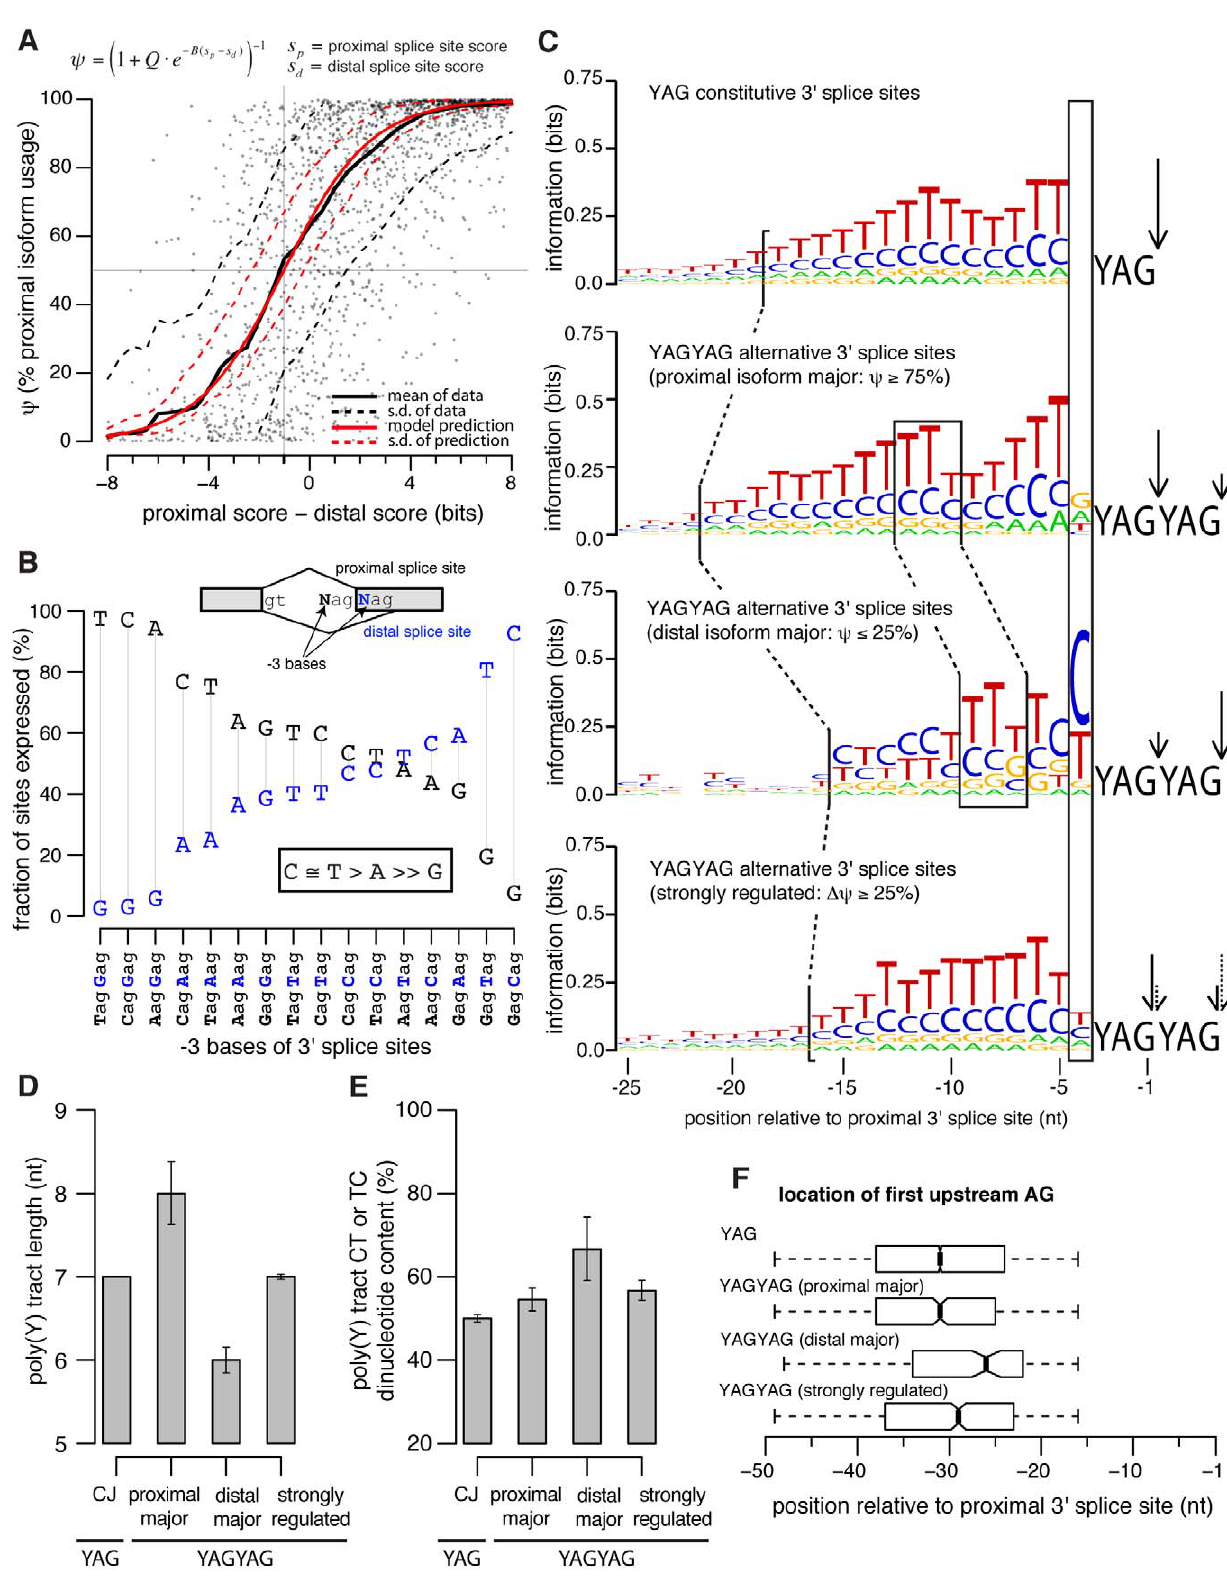
Figure 3. Variation in 3 9 splice site features are associated with differences in NAGNAG splicing. (A) A simple biophysical model of NAGNAG splicing accurately models mean isoform usage across tissues as a function of difference in 3 9 splice site score. Each point represents a single human NAGNAG, and the solid and dashed black lines show the mean y (across values for individual NAGNAGs with similar splice site score